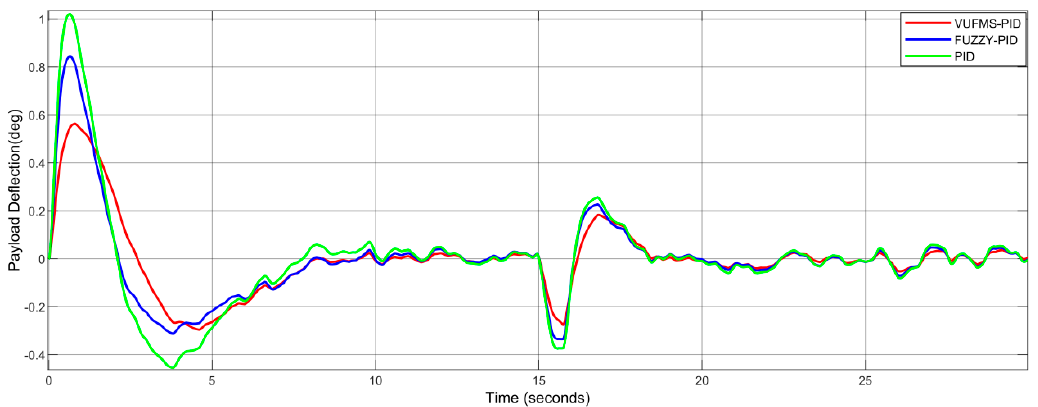
Figure 19. Trolley’s position using VUFMS-PID, FUZZY-PID and PID controller under working condition 3 with a crosswind and white noise.